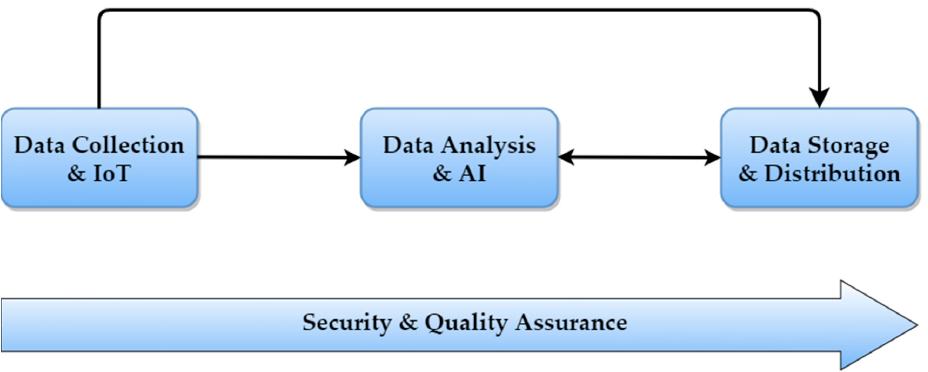
Figure 1. Proposed data lifecycle model.